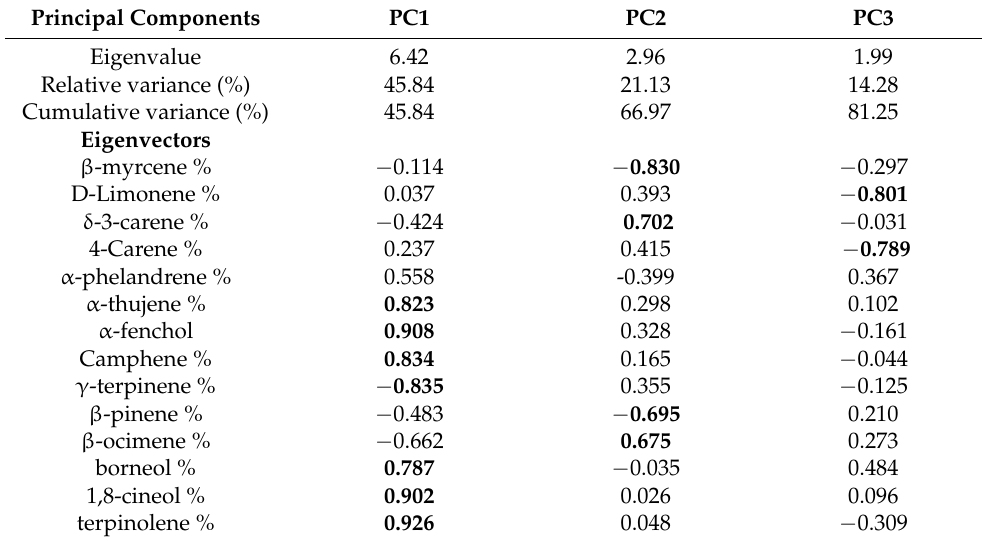
Table 3. Eigenvalues, the relative and cumulative percentage of the total variance, and correlation coefficient for monoterpenes compositions of the extracted essential oils with respect to the three principal components (PC1, PC2, and PC3).